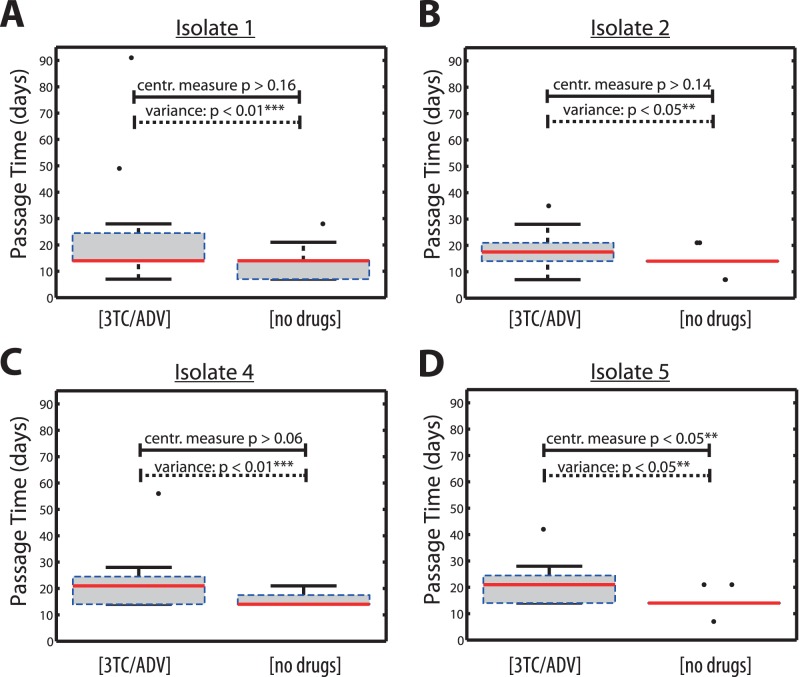
Box plot of passage times for virus isolate #1, #2, #4 & #5 during experimental set-ups A & B (no drugs added vs. 1 µM 3 TC plus 2 µM ADV added) as indicated on the x-axis.The solid red horizontal lines indicate the respective median passage times, whereas the boxes surrounding them indicate the range encompassed by the 25th and 75th percentiles. The whiskers denote the most extreme data points, which are not considered outliers and the black dots indicate outliers. A: Viral passage times for isolate #1. B: Viral passage times for isolate #2. C: Viral passage times for isolate #4. D: Viral passage times for isolate #5.